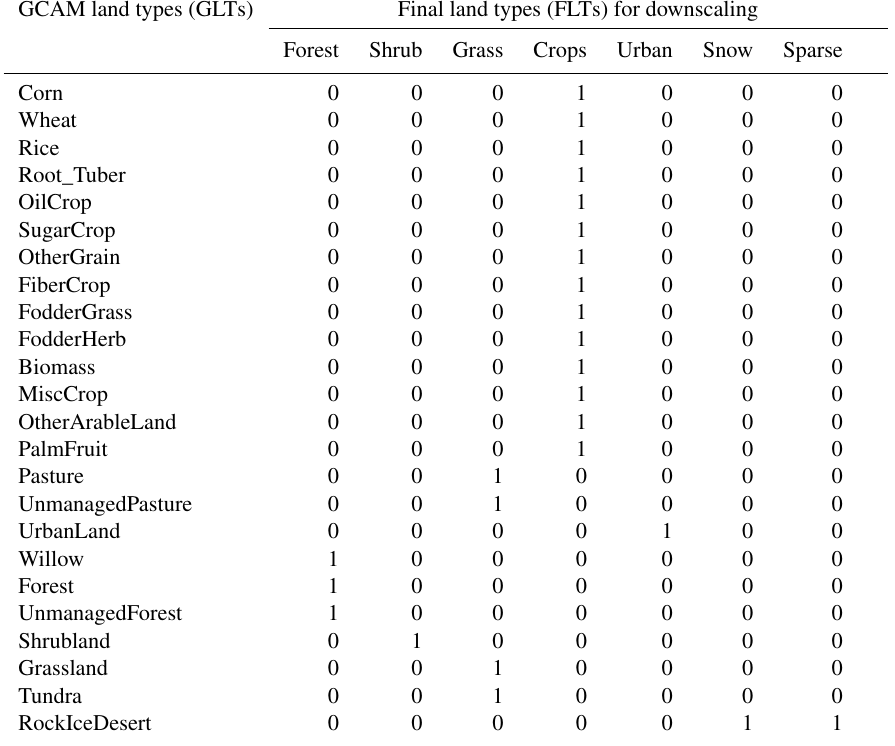
Table 3. User-defined aggregation of the GCAM data. GCAM land types (GLTs, rows) are attributed to the final land types (FLTs, columns) identified by the number 1. Several 1s in the same row means that the considered GLT will be split into the corresponding FLTs. For example, the RockIceDesert GLT is here aggregated into the snow and sparse FLTs. The actual share of the GLT going to each FLT is determined for each region/AEZ based on the share of those FLTs in the spatial data (see Sect. 3.1.2).